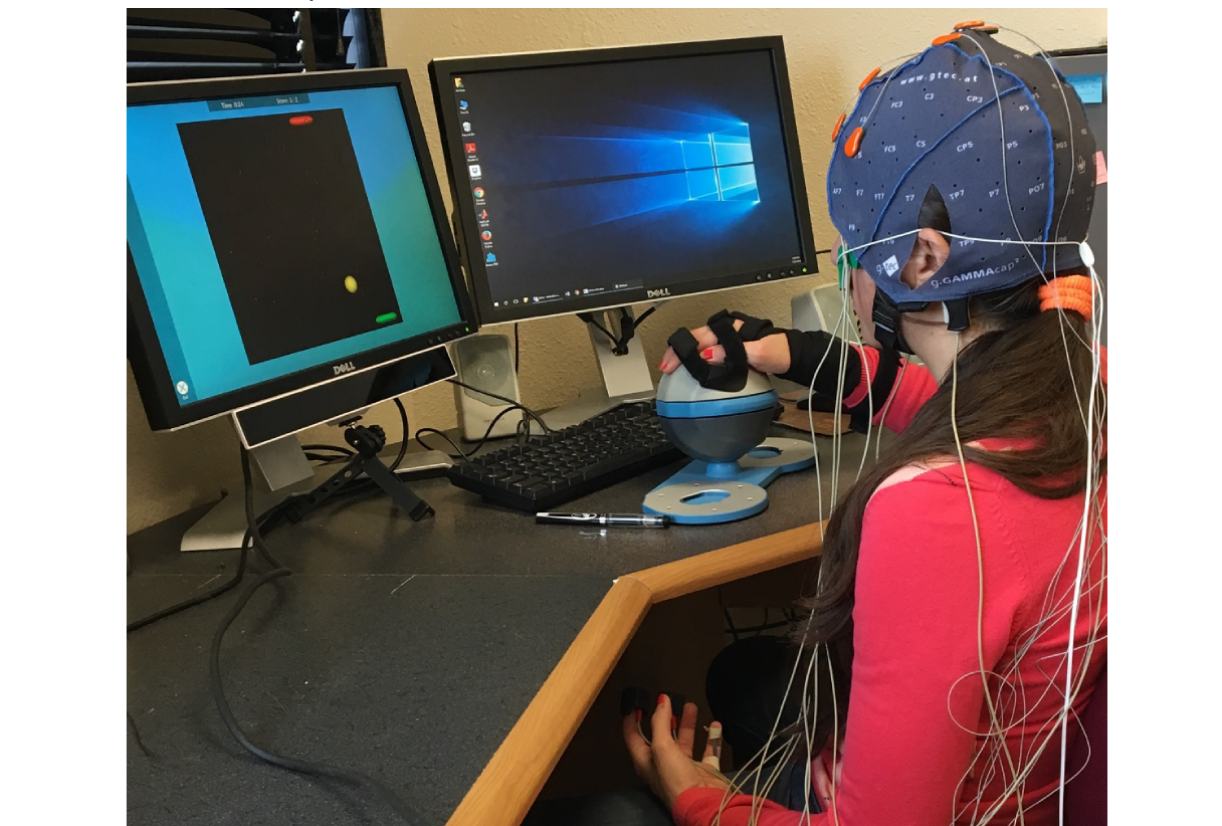
Figure 1. A participant playing the exergame (on the screen) using the Bimeo device (right hand) while wearing the different physiological sensors on the head and nondominant hand. The eye tracker is visible below the